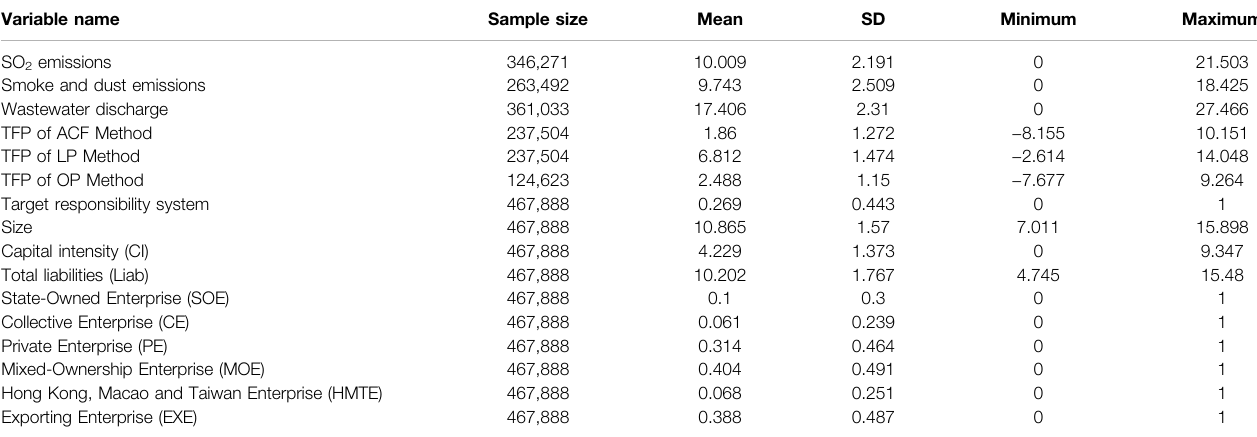
TABLE 2 | Descriptive statistics of variables.